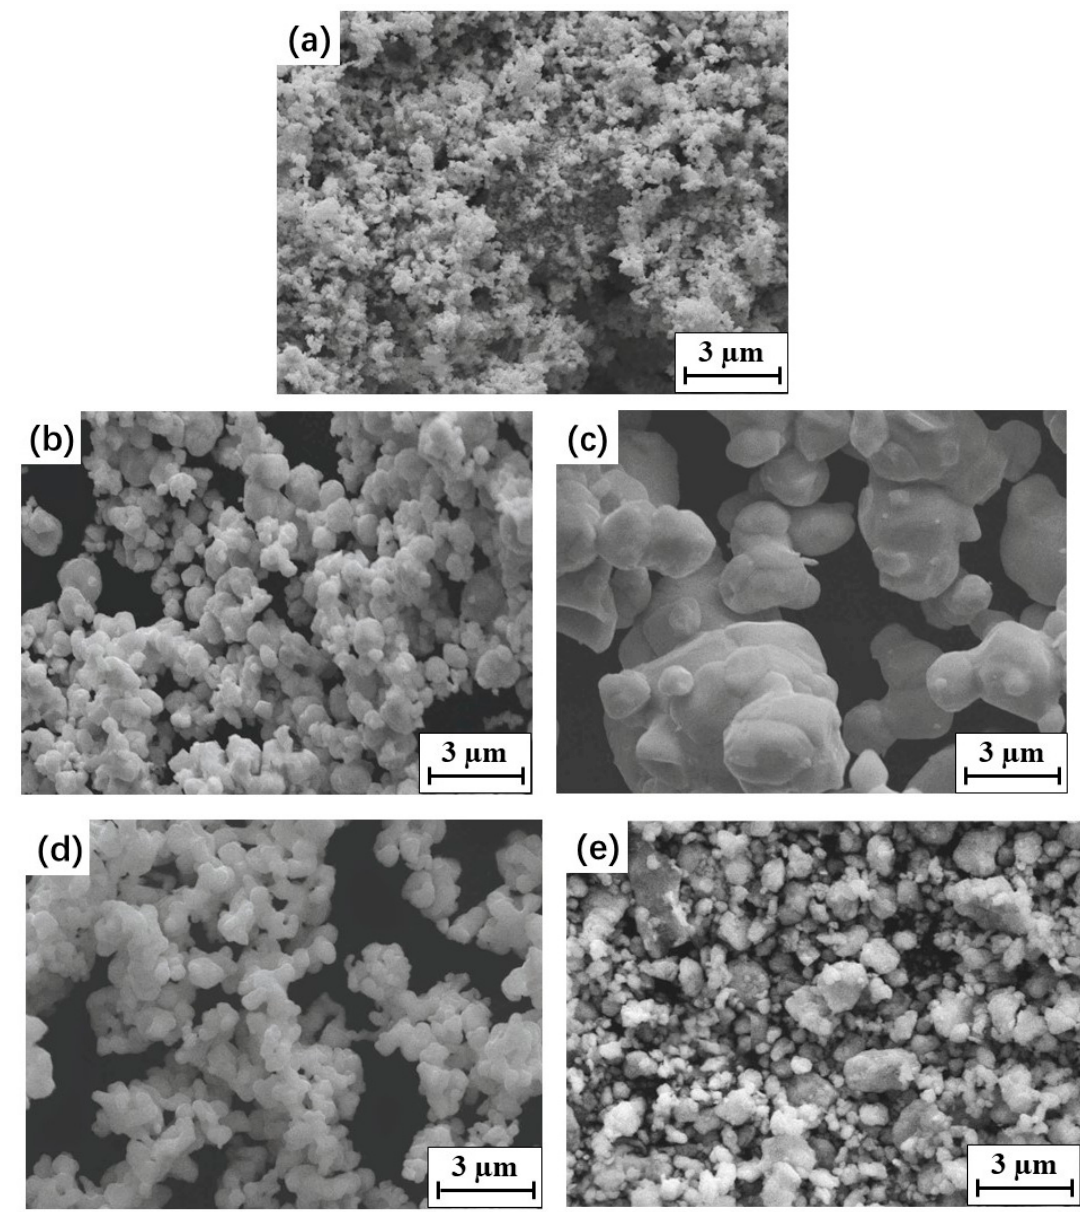
Figure 1. Morphology of the WC, Co, and Cr starting powders: ( a ) nano WC, ( b ) medium WC, ( c ) coarse WC, ( d ) Co, ( e ) Cr.